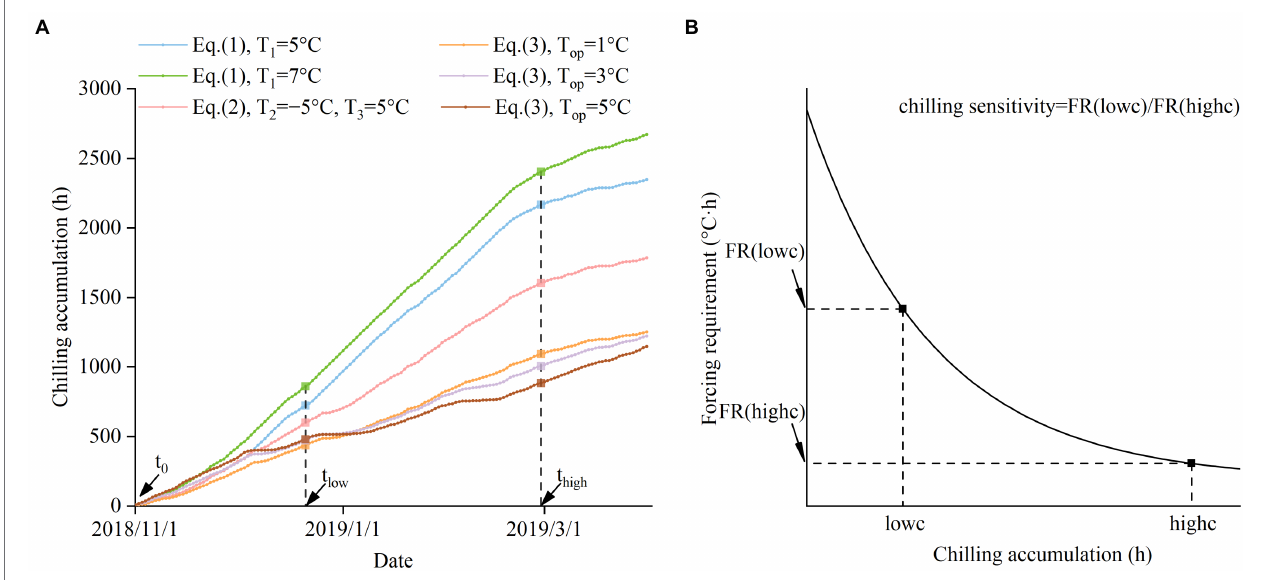
FIGURE 1 | Schematic diagram of the method to calculate the chilling sensitivity (CS). (A) The definition of low chilling condition (lowc) and high chilling condition (highc). lowc is defined as the CA from 1 November 2018 (t 0 ) to 21 December 2018 (t low ). highc is defined as the CA from 1 November 2018 (t 0 ) to 28 February 2019 (t high ). For each species, different chilling models are used to calculate lowc and highc. (B) The definition of CS. CS is the ratio of the FR in lowc to the FR in